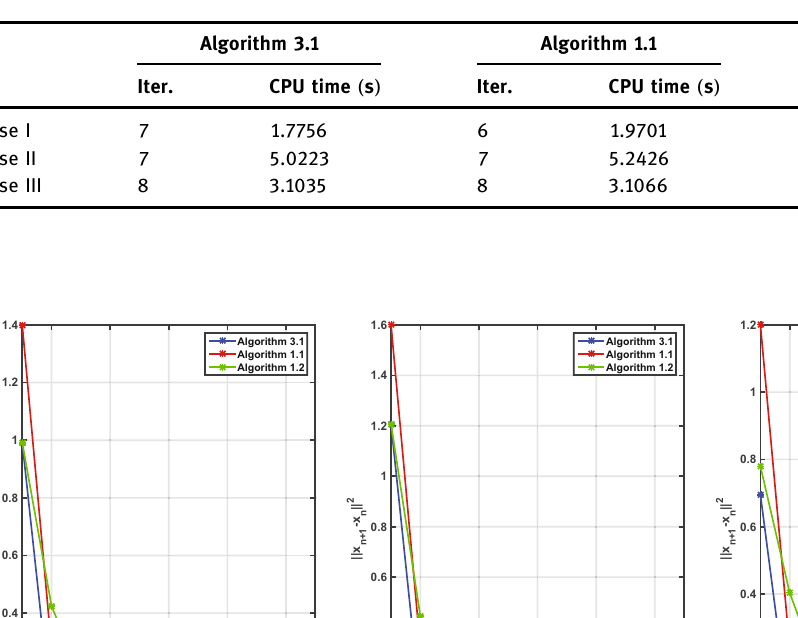
Table 2: Comparison between Algorithms 3.1, 1.1, and 1.2 for Problem 2